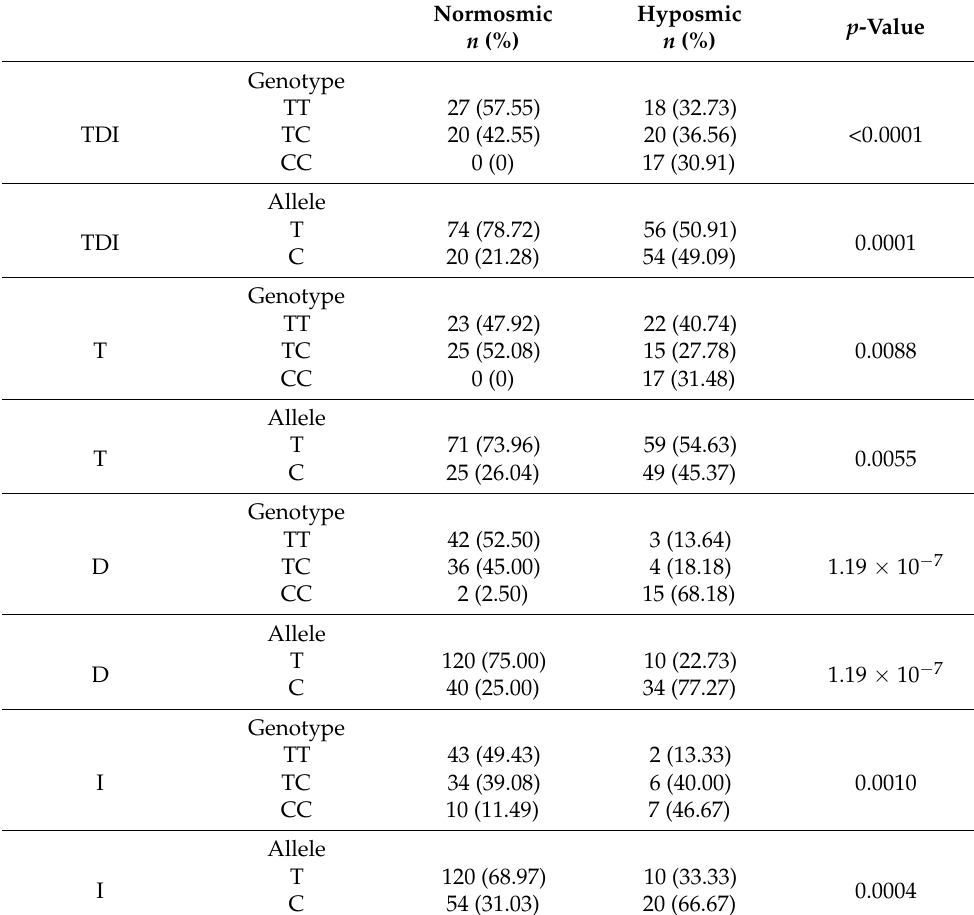
Table 1. Genotype distribution and allele frequencies of the rs2821557 polymorphism of the Kv1.3 gene ( T/C ) in the subjects classified as normosmic or hyposmic on the basis of the TDI, T, D and I olfactory scores